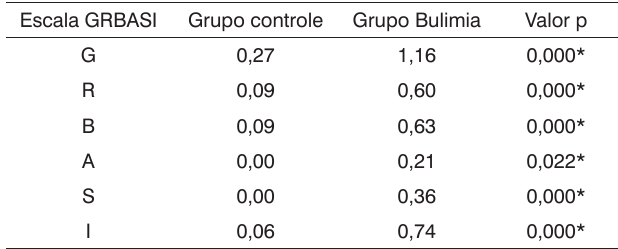
Tabela 2. Valores médios do grau de severidade dos parâmetros da escala GRBASI nos grupos